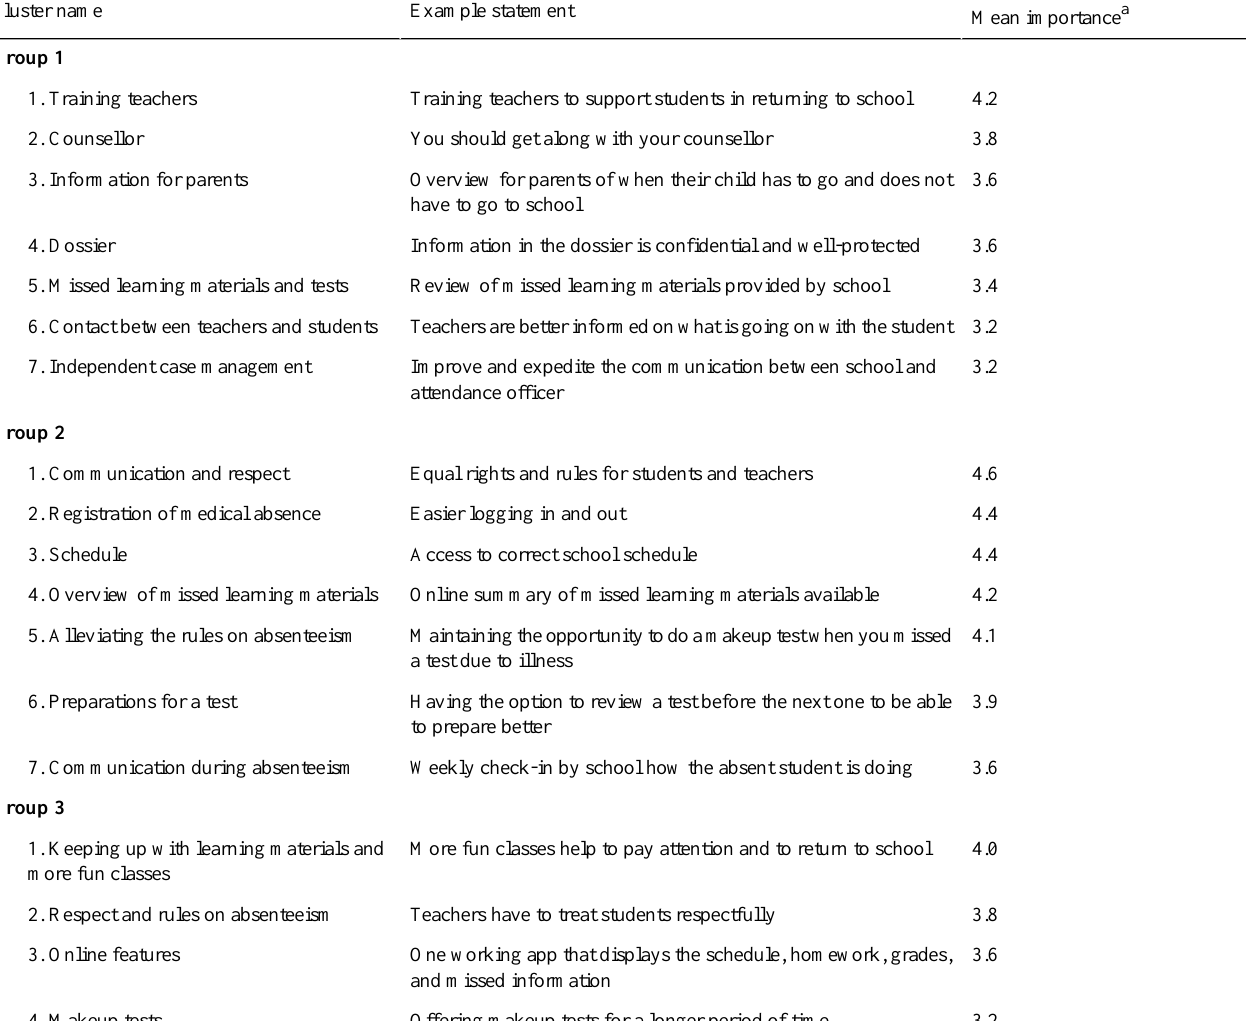
Table 4. Clusters, associated example statements, and mean importance ratings per group concerning the perspectives and needs of students for a supportive tool in reducing school